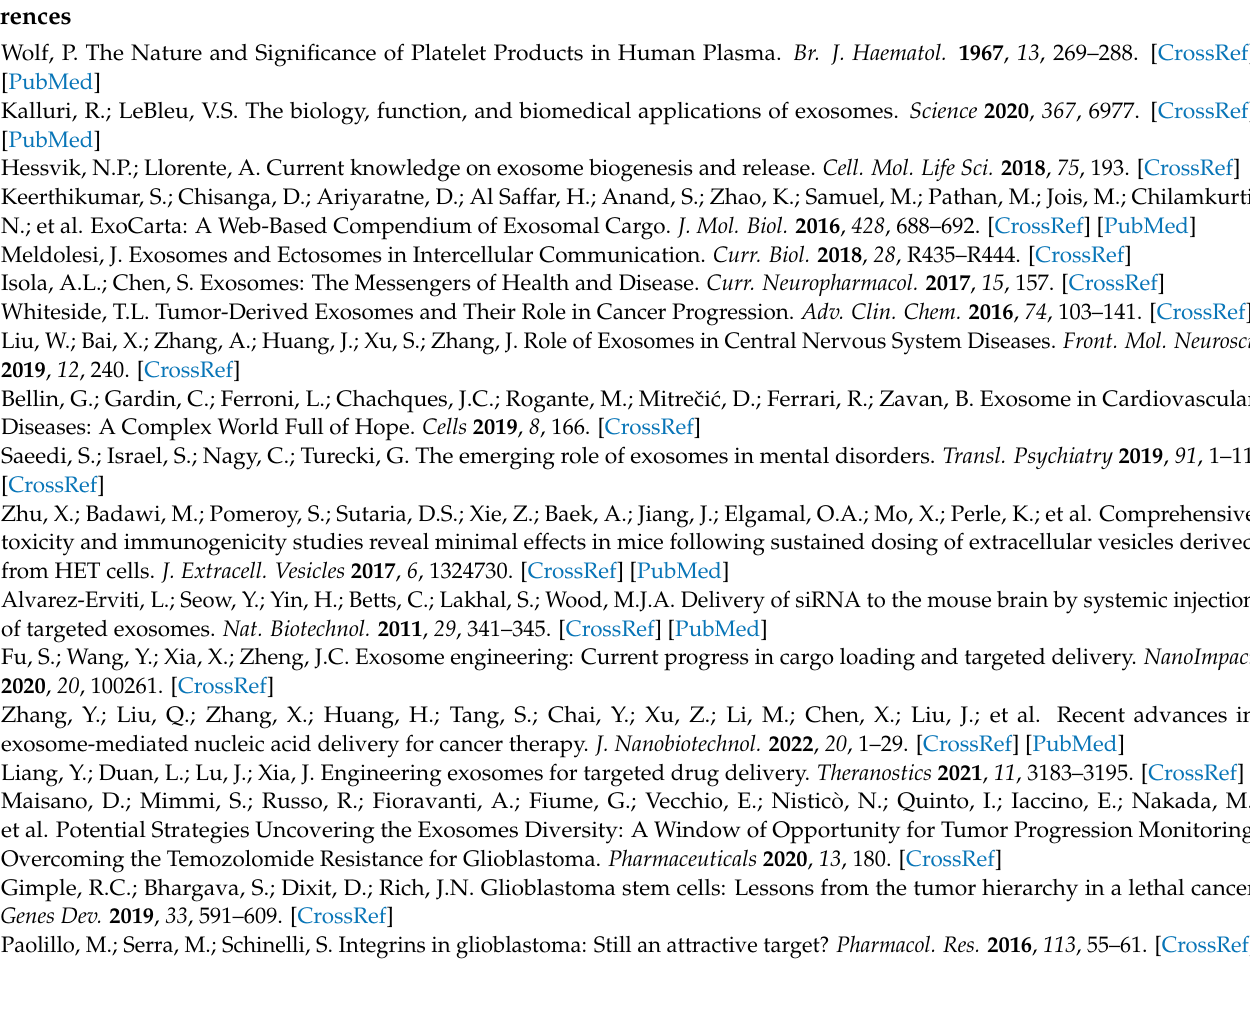
Figure A4. In Vitro DOX release profile. A 2 mL volume of EV-encapsulated DOX solution (130 ng/mL) was transferred to dialysis tubes (D977-100FT, Sigma Aldrich, Hoeilaart, Belgium), immersed in PBS at pH 7.4 and incubated at 37 °C. The release of EV-DOX was analysed at 7 time points (0.5, 1, 2, 5, 10, 24 and 48 h). Concentrations of DOX were measured by red fluorescence intensity and determined by calibration curve on Qubit 3.0 fluorimeter (Life Technologies, Thermo Fisher Scientific, Bleiswijk, The Netherlands). After performing drug release profile analysis of EV-DOX. No significant differences were observed between native and RGD-EVs. In PBS dialysate, the release rate of Exo-Dox was rapid and reached about 70% in the first 5 h.